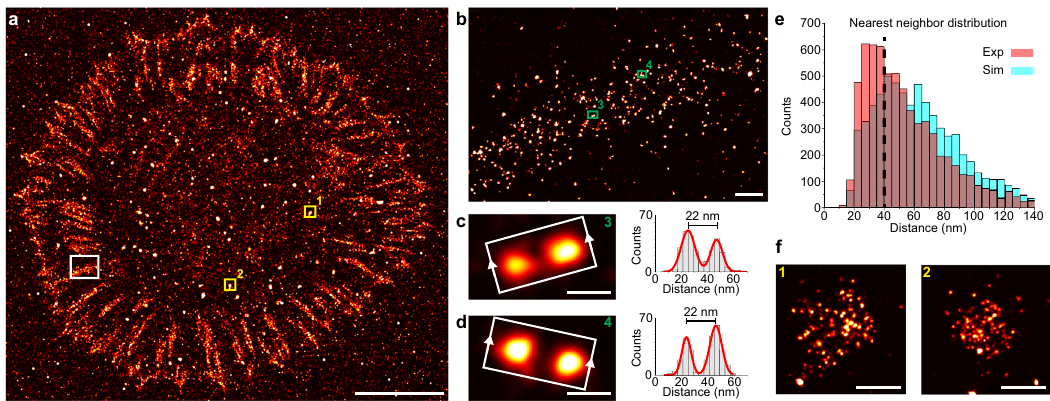
Fig. 3 Nanoscale pattern analysis of open hairpin sensors. a Super-resolved DNA-PAINT image of open hairpin sensors as proxy for mechanically engaged ligand-receptor pairs, enriched in focal adhesions. b Zoom-in of the highlighted area (white) in a . c , d Zoom-ins of the highlighted areas (green) from b reveal closely spaced sensors (left), approximately 22 nm apart (right). e Comparison of experimental NND distribution of extended hairpins within focal adhesion areas selected by colocalization with diffraction-limited talin signal and NND of random simulated sites with same molecular density of 88.5 molecules per µ m 2 reveals molecular clustering below 40 nm of extended sensors. f Zoom-in of two nanoclusters highlighted in yellow in a in non-adhesion areas were found to have an average diameter of 228.3 nm. Scale bars: 10 µ m ( a ), 300 nm ( b ), 20 nm ( c , d ), 200 nm ( f